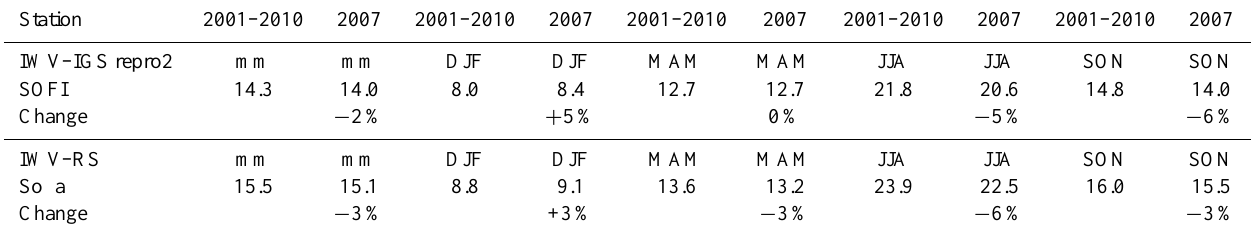
Table 3. Columns 1–3 are the station name and annual mean for 2001–2010 and 2007 respectively; columns 4–5: winter DJF (December, January and February) mean for 2001–2010 and 2007; columns 6–7: spring MAM (March, April and May) mean for 2001–2010 and 2007; columns 8–9: summer JJA (June, July and August) mean for 2001–2010 and 2007; columns 10–11: autumn SON (September, October and November) mean for 2001–2010 and 2007. The 2007 departure from the 2001–2010 mean is given in % in the brackets.